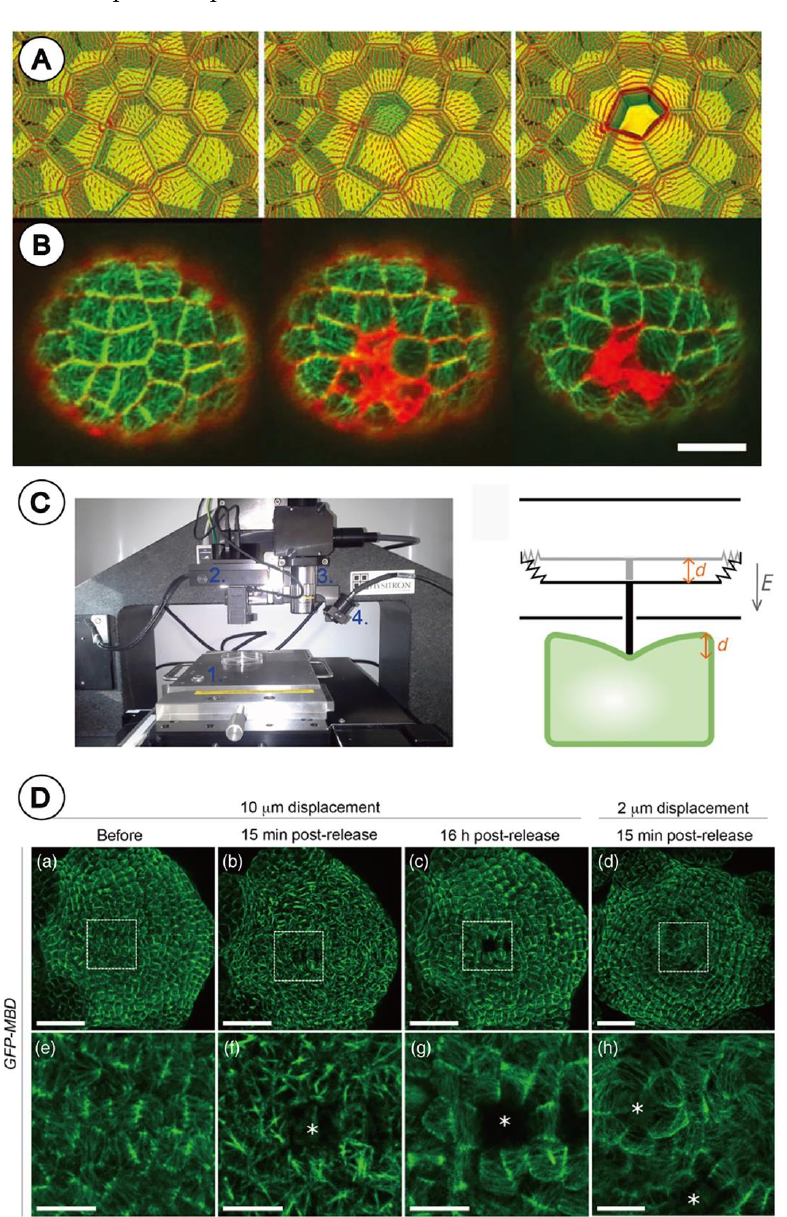
Figure 3. Laser ablation experiment ( A , B ) and nano-indentation experiment ( C , D ): ( A ) theoretical principal stress direction pattern (red lines) in epidermis cells of floral meristem before and after laser ablation. Color gives relative values of maximal stress (green, low; yellow, high). Left: a stress pattern in a group of cells before ablation. Middle: radial stress after drop of tensile stress in a ablated cell at center. Right: circumferential stress after weakening of top wall. ( B ) GFP-MBD expression (green) in epidermis cells of floral meristem in A rabidopsis thaliana. Left: before laser ablation. Middle: just after laser ablation. Right: 6 h 30 min after laser ablation. Ablated cells are shown in red (FM4-64 stain- ing). ( C ) Nano-indentation. Left: indenter; (1) motorized stage; (2) tip and transducer; (3) × 10 objective lenses; (4) bright light. Right: drawing of transducer (bold black line) indent- ing a floral meristem (green object). When a voltage difference is applied between plates (thin black lines), an electrostatic field E is created, forcing middle plate to move over a